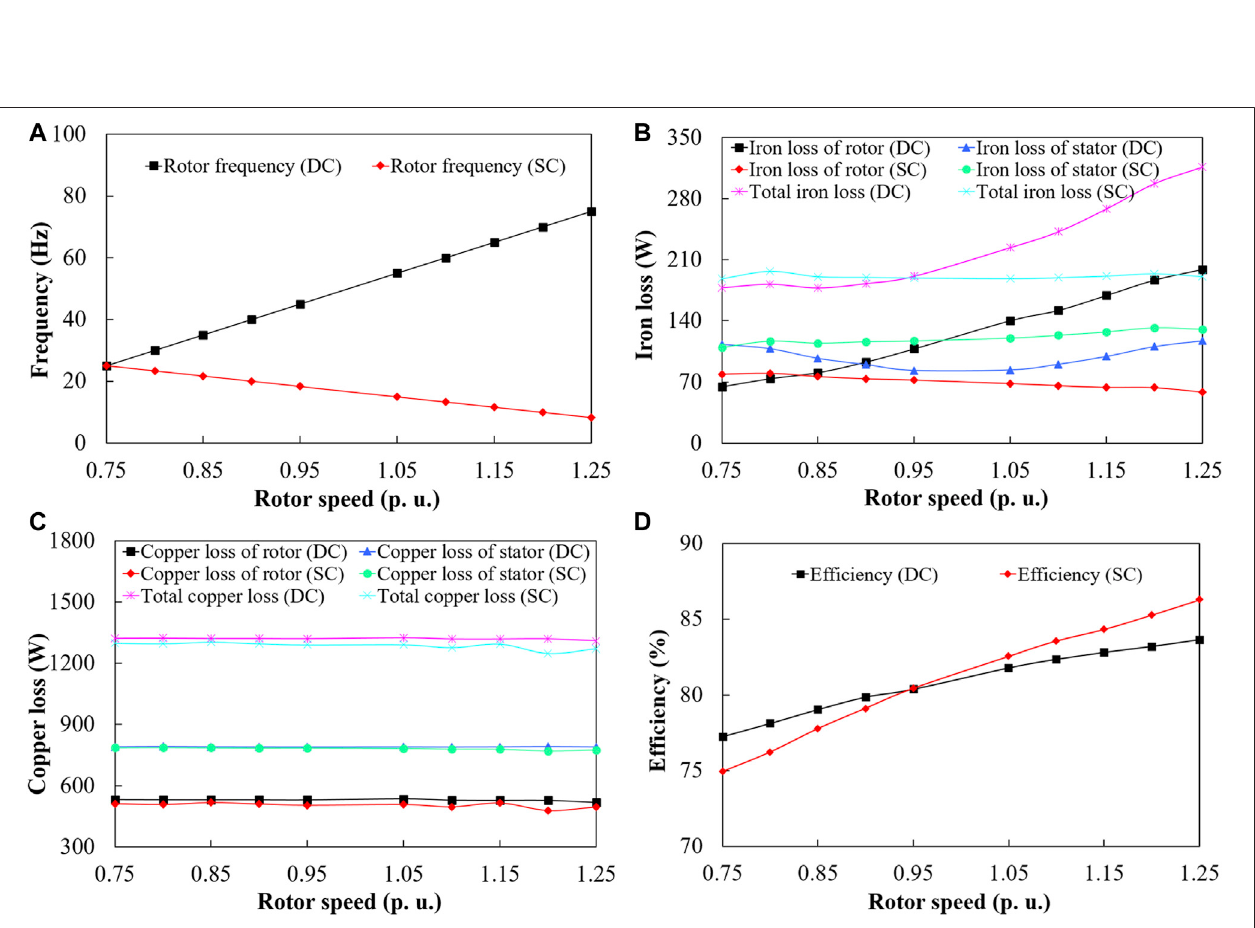
FIGURE8| Comparisonsofrotorfrequency,ironloss,copperlossandef fi ciencyforDCandSCmodes (A) Rotorfrequenciesversusrotorspeed (B) Ironlossesof rotor and stator versus rotor speed (C) Copper losses of rotor and stator versus rotor speed (D) Ef fi ciencies versus rotor speed.